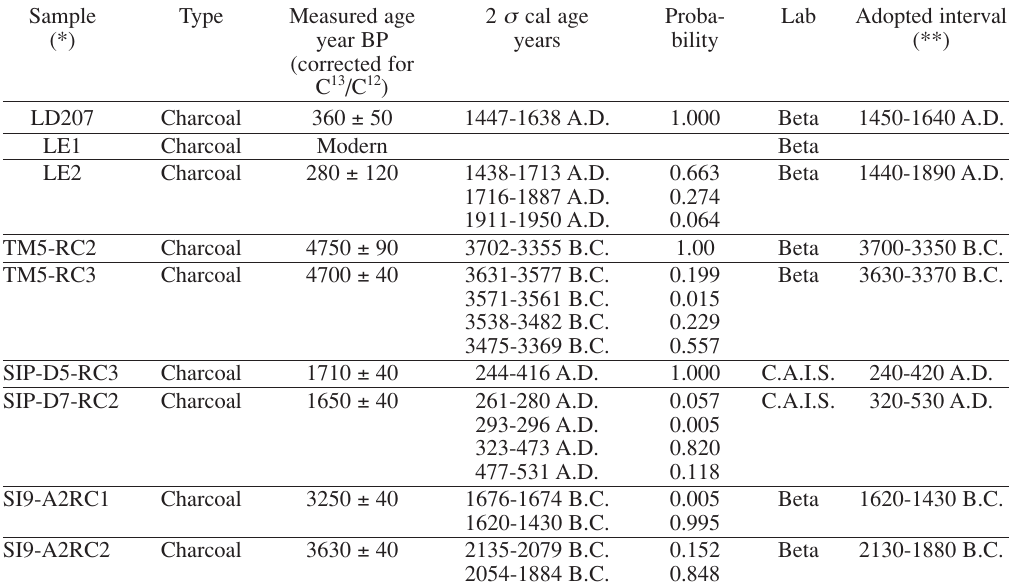
Table I. Measured and calibrated ages (according to Calib 4.3 by Stuiver et al. , 1998a,b) of the samples col- lected in the ditches and cores.